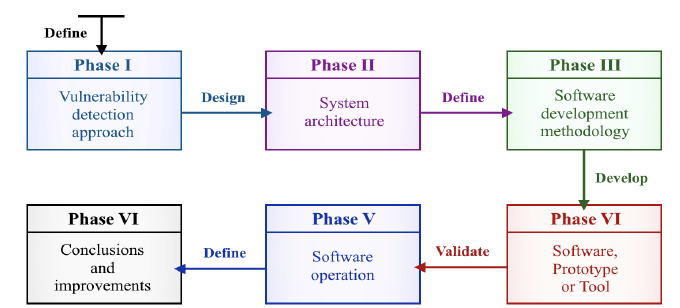
Figure 4. Development Process Phases. The six-phase process allows us to constantly evaluate the software, control complexity and risks, and increase its functionality throughout the